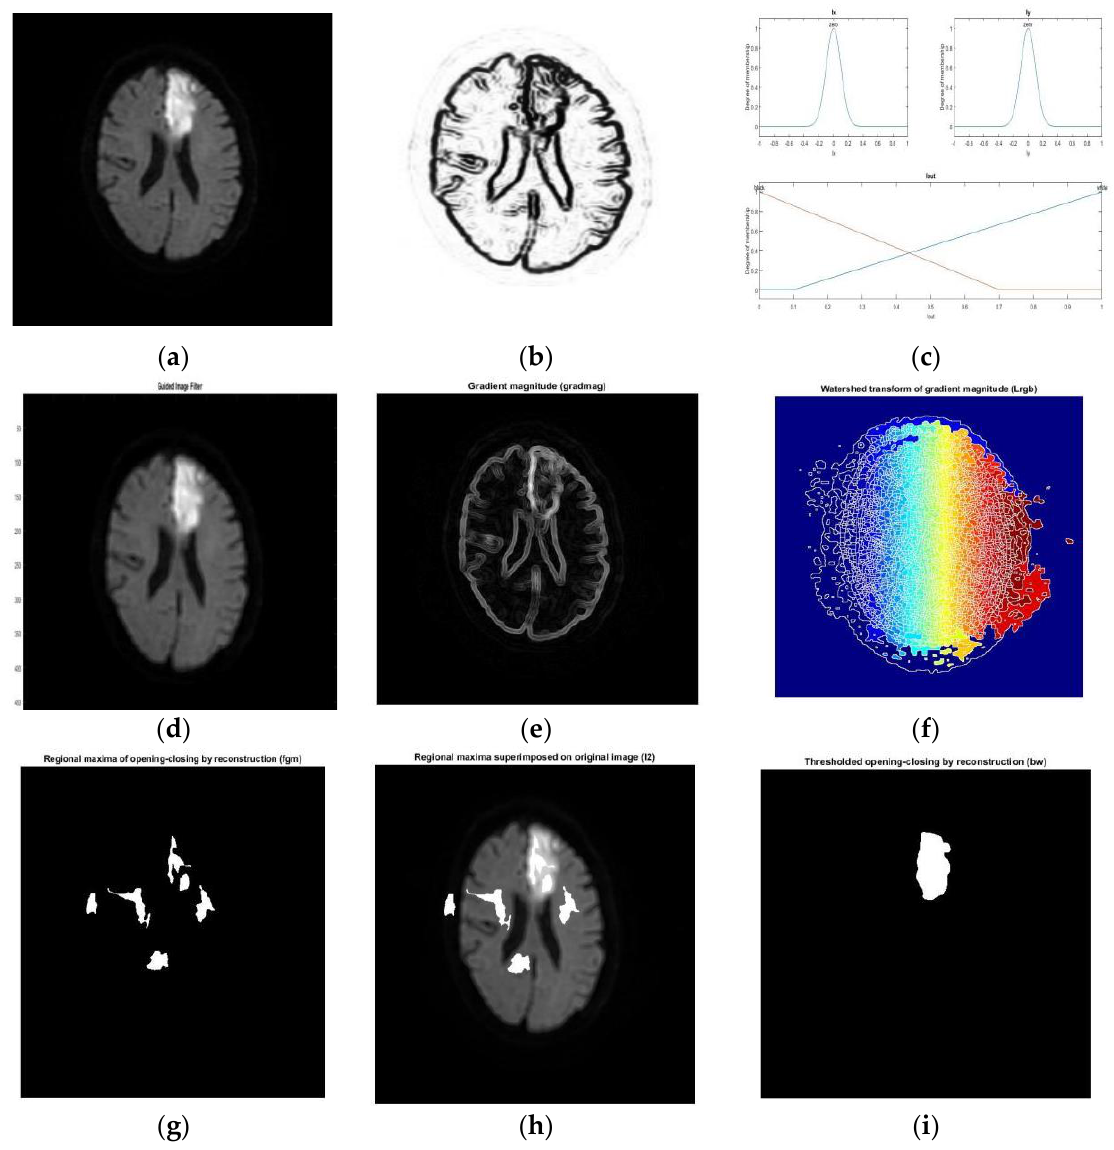
Figure 5. Watershed segmentation of brain infarcts: ( a ) original image ( b ) Edge detection with fuzziness; ( c ) Membership function; ( d ) Output of guided filter; ( e ) Gradient magnitude image; ( f ) output of watershed transform; ( g ) Reconstruction of image; ( h ) Superimposed image on original image; ( i ) Final detected infarct with morphological operation [89].